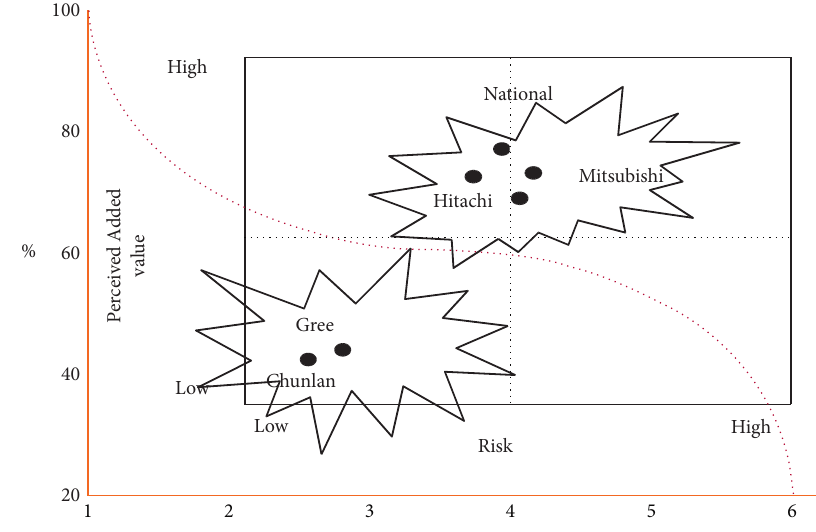
Figure 5: The exponential region of the discharge